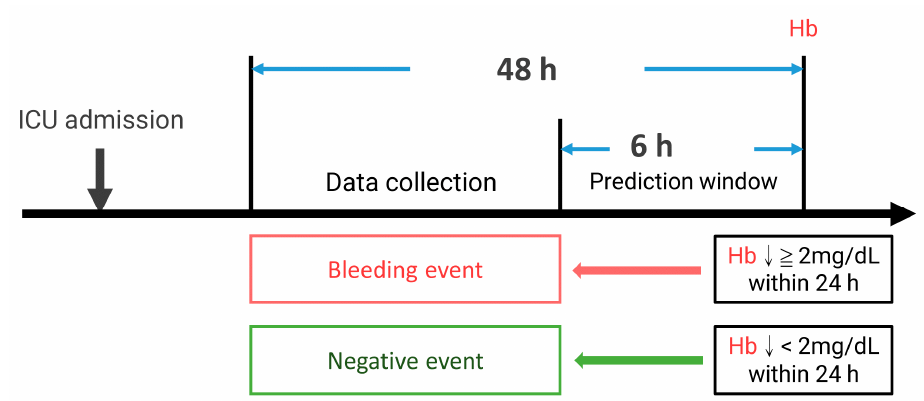
Figure 2. The definition of events and data collection. ↓: drop.